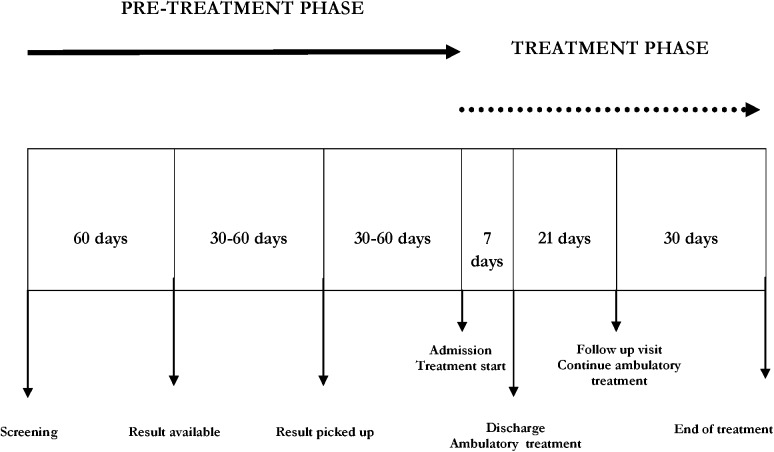
Timing of program components in a Chagas disease program in Bergamo, Italy, 1st June 2012-30th June 2013.